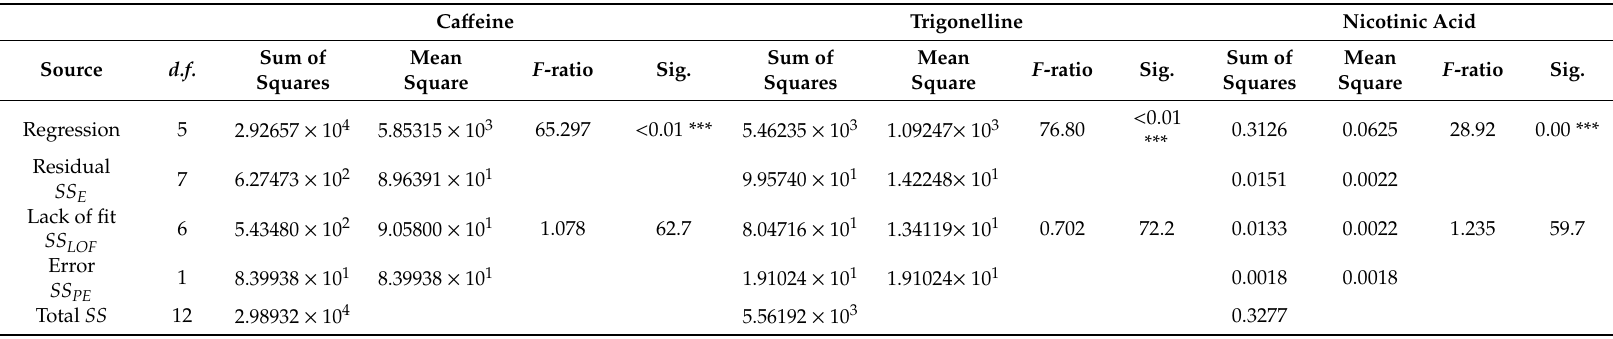
Table 7. ANOVA for the quadratic experimental models for ca ff eine, trigonelline, and nicotinic acid estimated on the complete experimental data set. Ca ff eine Trigonelline Nicotinic Acid Source d.f. Sig. F -ratio